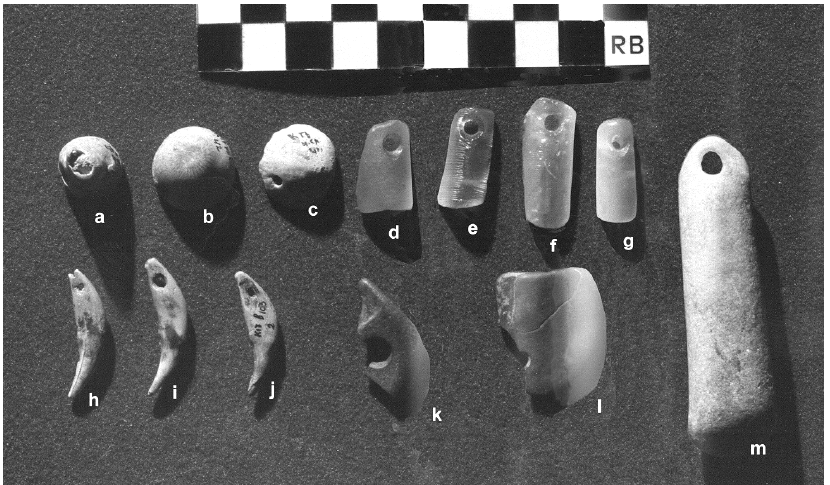
Figure 5. Thirteen pendants from stratum 2 of Kostenki 17, a >40-ka-old Spitzinian occupation: three polar fox canines, three perforated gastropod shells, four belemnite fragments and three stone objects; all probably the work of